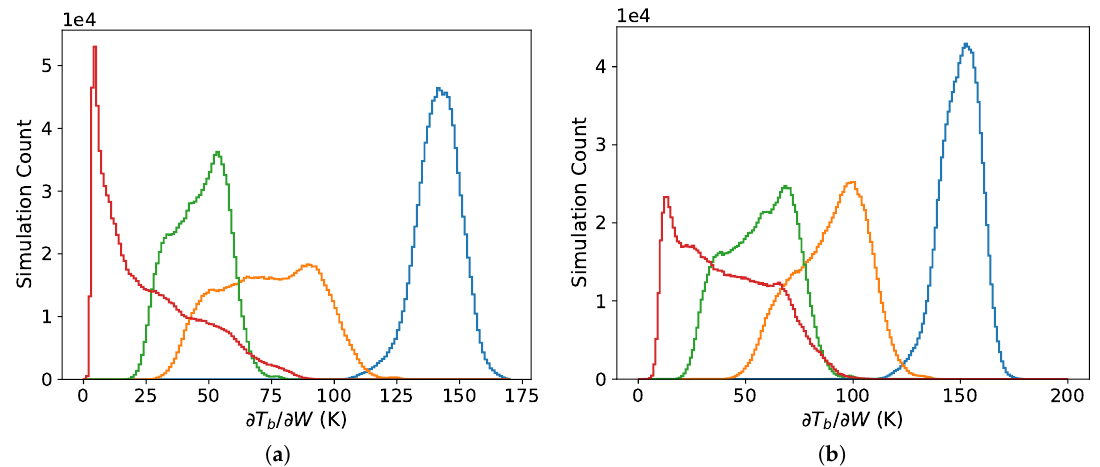
Figure 5. Distributions of ∂ T B / ∂ W at 1 km altitude ( a ) and the surface ( b ) H polarization and 53 ◦ EIA at frequencies of 37 (blue), 89 (orange), 113 (green) and 150 GHz (red).